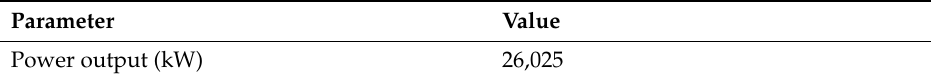
Table 4. Objective function.